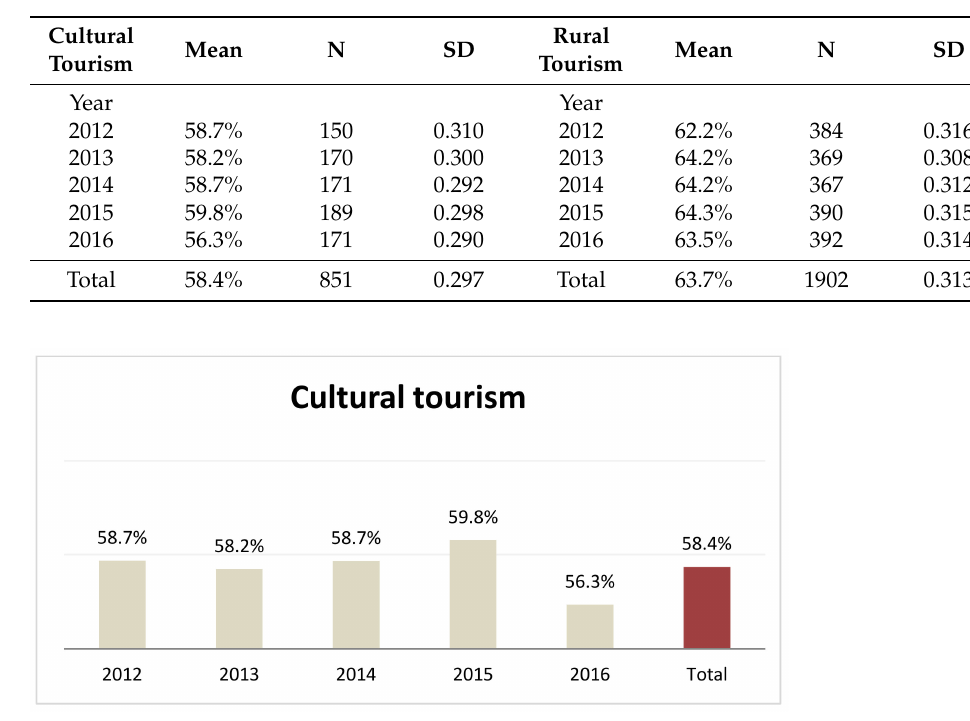
Figure 4. Efficiency results in cultural tourism firms by